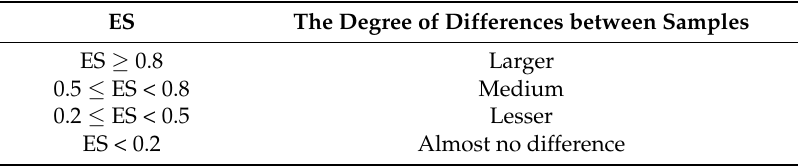
Table 2. Effect size (ES) and the empirical value of sample differences.